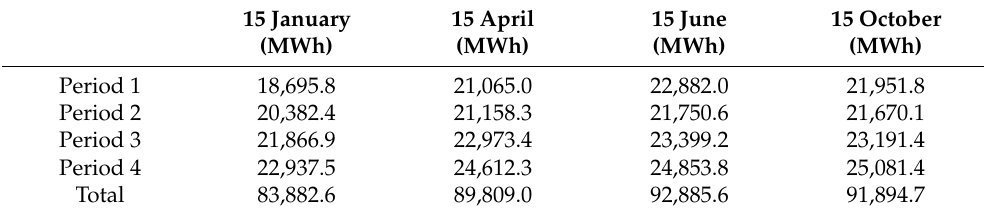
Table 4. Electricity generation by period on the four studied seasonal